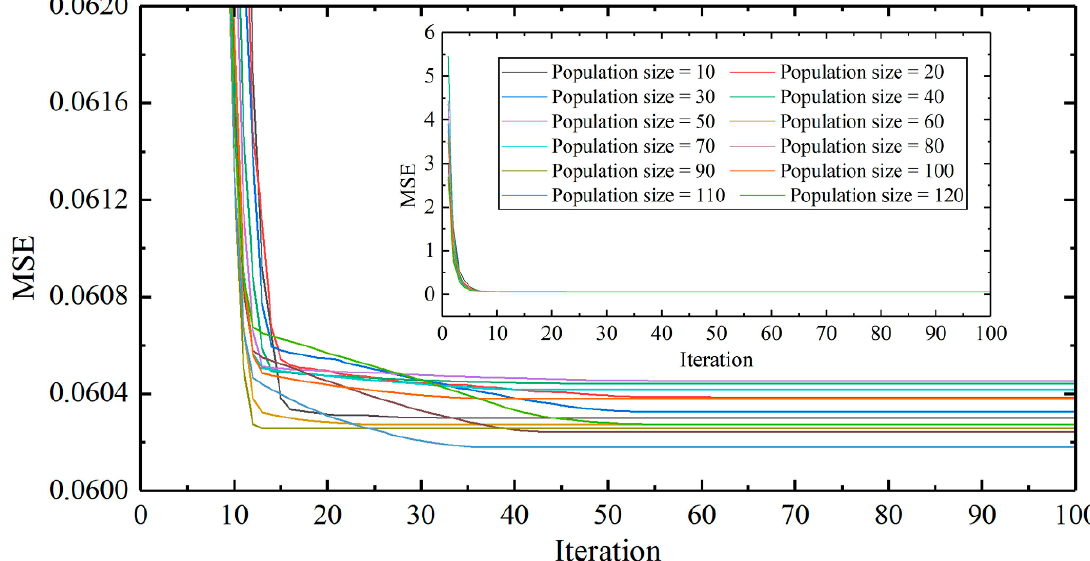
Figure 13. A population-based sensitivity analysis for the FOA-BPNN model.